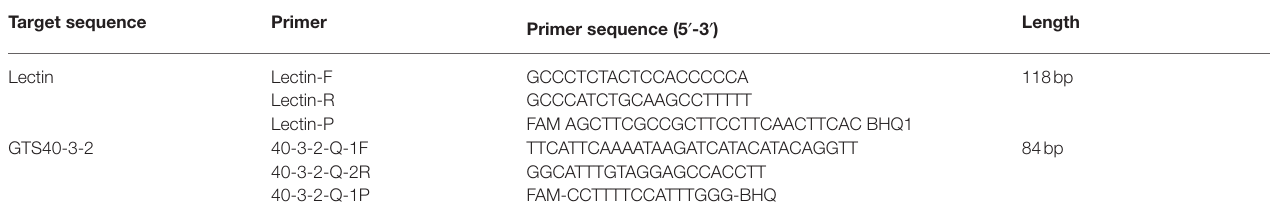
TABLE 2 | Sequence of primers and probes used for copy number determination of genetically modified soybean. Target sequence Primer Primer sequence (5